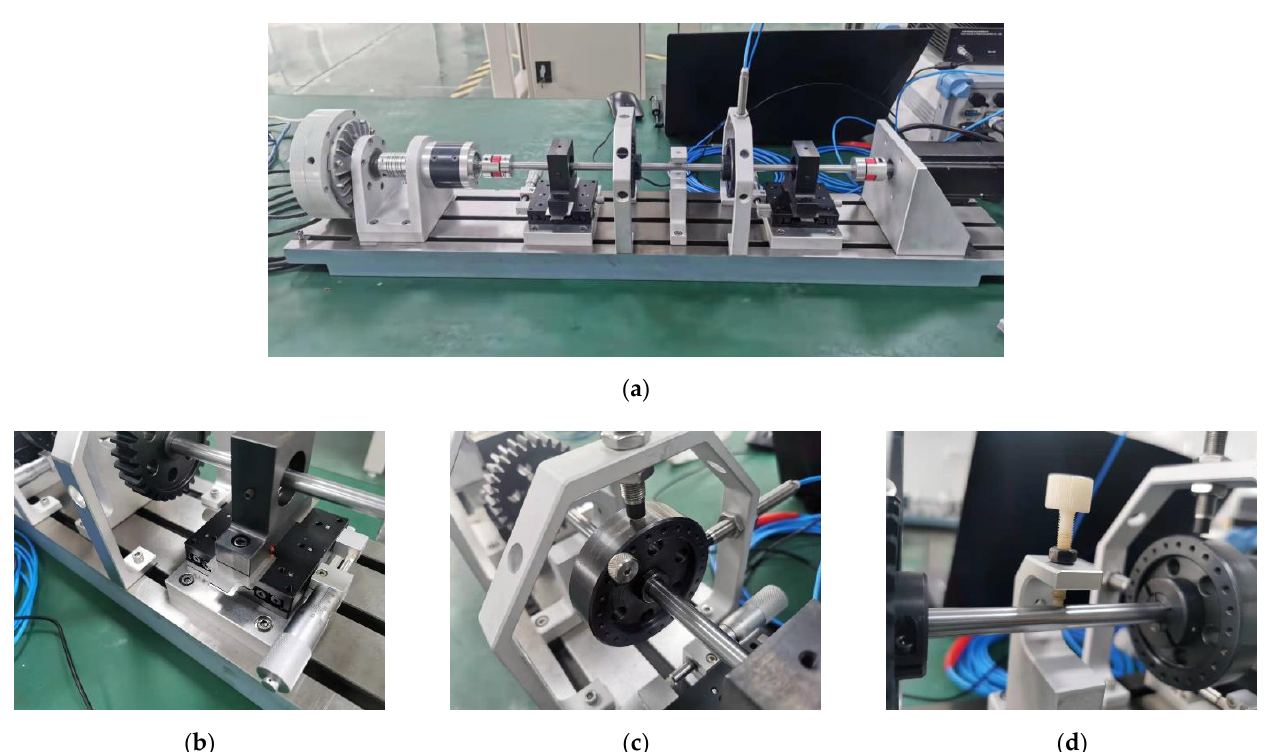
Figure 8. HZXT-008 rotor rolling-bearing comprehensive fault-simulation test bench and the installation of fault components: ( a ) test bench; ( b ) unbalance adjustment parts; ( c ) mass block; ( d ) rubbing parts.